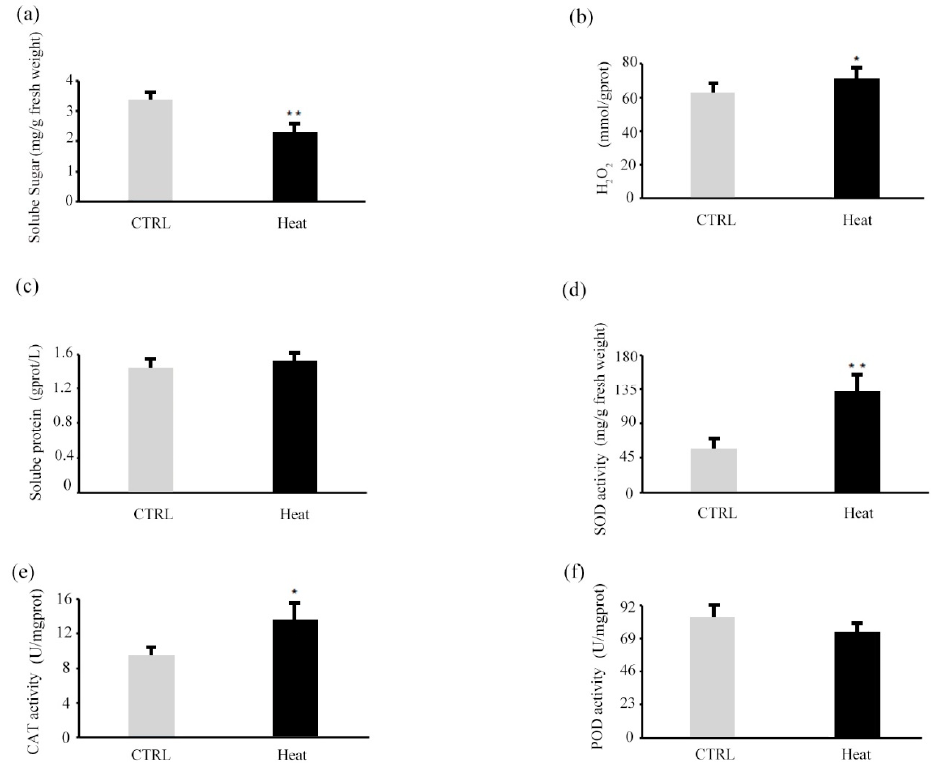
Figure 3. Changes in physiological and biochemical indices at 45 °C high temperature. ( a ) Soluble sugar; ( b ) H 2 O 2 ; ( c ) soluble protein; ( d ) superoxide dismutase (SOD) activity; ( e ) catalase (CAT) activity; ( f ) peroxidase (POD) activity. Bars indicate means ± SE ( n = 3). * p < 0.05; ** p < 0.01.